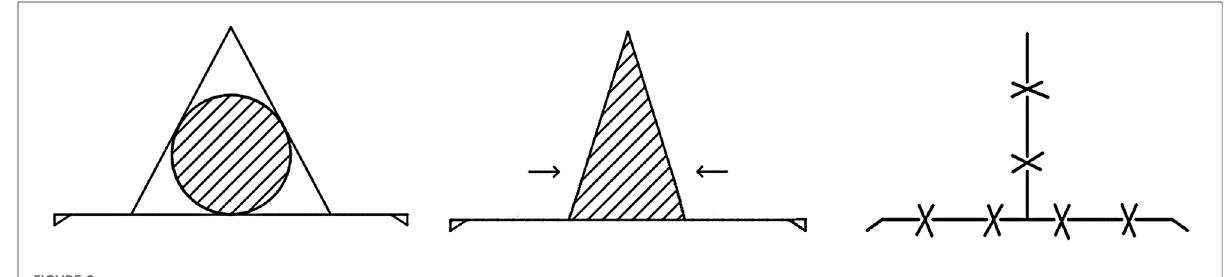
FIGURE 2 Operation process.